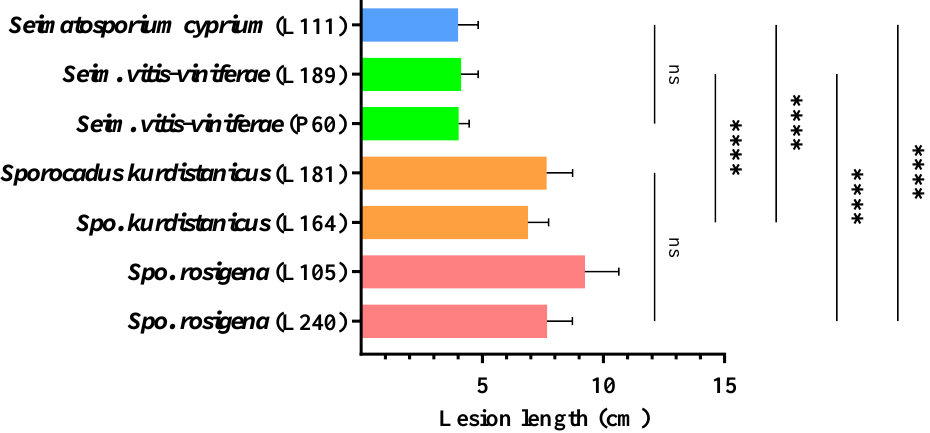
Figure 8. Mean lesion lengths caused 12 months post-inoculation by Sporocadaceae isolates on 2-year- old vines (cv. Xynisteri) during pathogenicity assays under field conditions. Each bar represents an individual tested isolate (n = 10), and vertical error bars indicate the corresponding standard deviation. Asterisks (****) and ns indicate the statistically significant ( p < 0.0001) and non-significant differences ( p < 0.05), respectively, following the analysis of variance and Tukey’s mean separation test procedures.